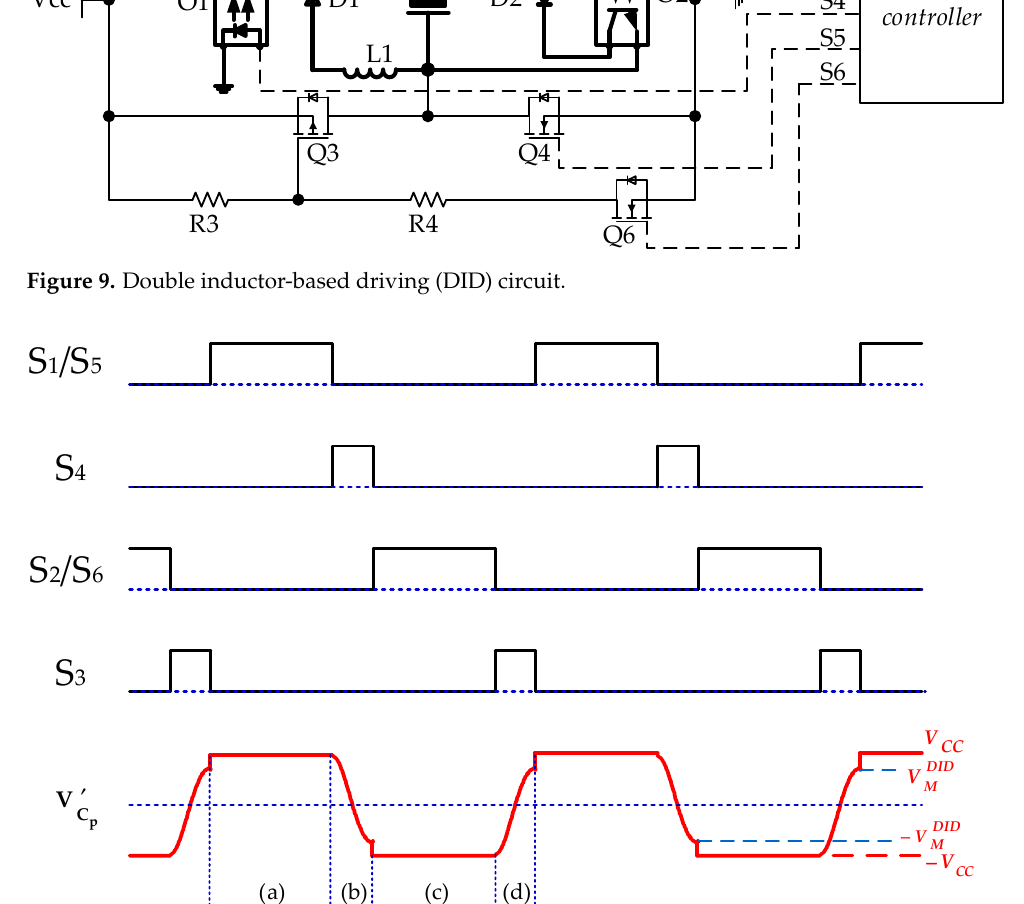
Figure 10. Switching waveforms of the DID circuit.